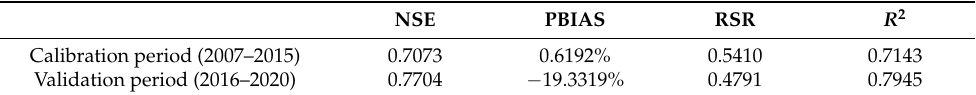
Table 2. Calibration and validation of the streamflow statistical daily